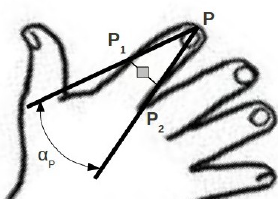
Figure 5. Curvature calculation.